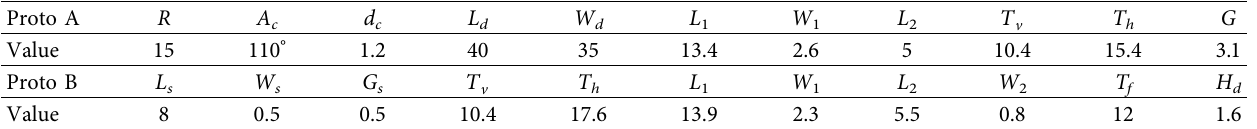
Figure 6: (a) Geometry of Proto A. (b) Top view of Proto B. (c) Perspective view of Proto B. (d) Side view of Proto B. Table 1: Dimensions of Proto A and Proto B (unit: mm).